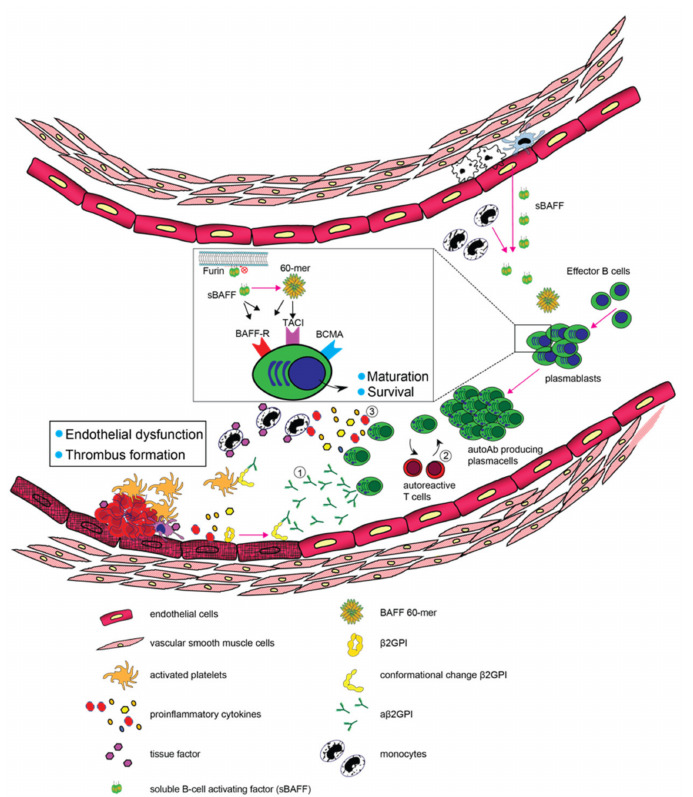
Figure 1. Schematic representation of the contributive role of B-cells and BAFF in the pathogenesis of APS. Growing evidence suggests that the abundance of pathogenic B-cells and BAFF may deteriorate clinical and immunological patterns in APS by promoting (1) the generation of plasma cells and production of autoantibodies, (2) stimulation of autoreactive T cells and (3) the production of pro- inflammatory